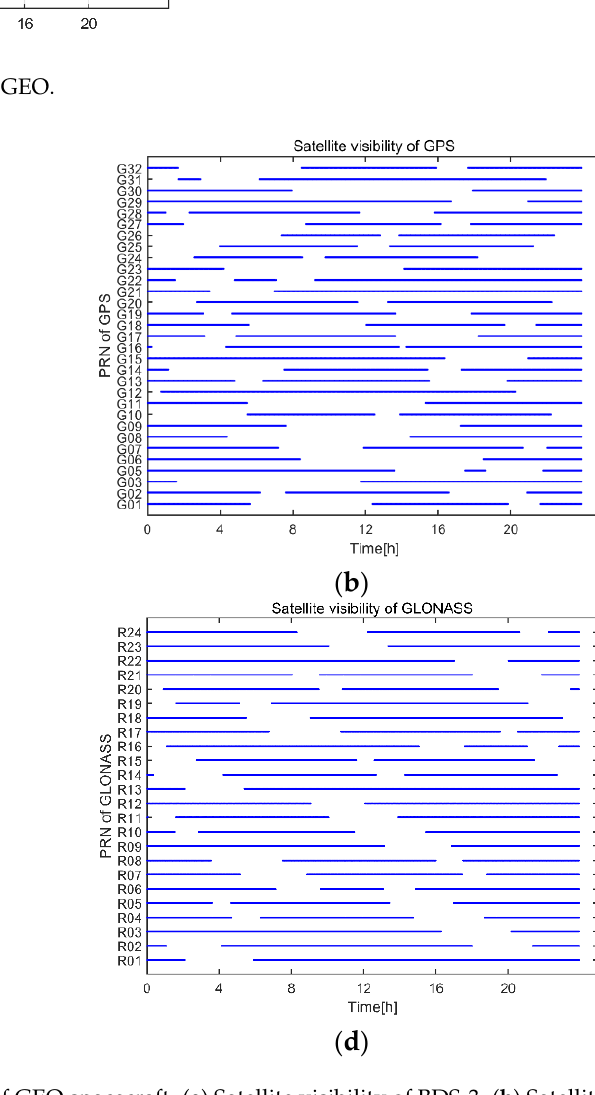
Figure 9. Satellite visibility of GEO spacecraft. ( a ) Satellite visibility of BDS-3. ( b ) Satellite visibility of GPS. ( c ) Satellite visibility of Galileo. ( d ) Satellite visibility of GLONASS.